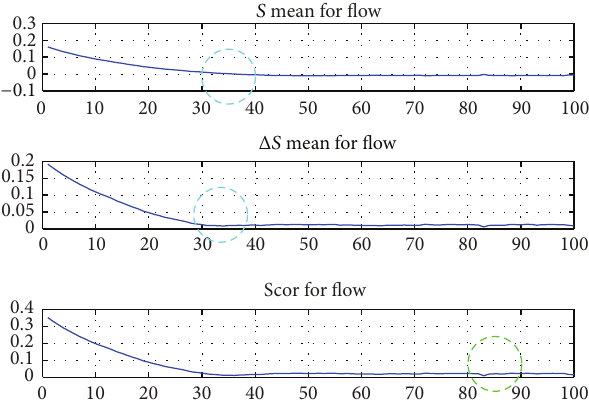
Figure 6: C-C method result for flow time series. According to Kim et al.’s work [26], delay time 𝜏 𝑑 = 𝑡 ⋅ 𝜏 𝑠 (𝜏 𝑠 = 1) can be deduced from the first zero crossing of 𝑆 mean or the first local minimum of delta 𝑆 mean in the blue circle zones, according to the minimum of 𝑆 ⋅ (𝑚 − 1) in the green circle zone; then the integral embedding 𝜏 𝑑 dimension 𝑚 can be